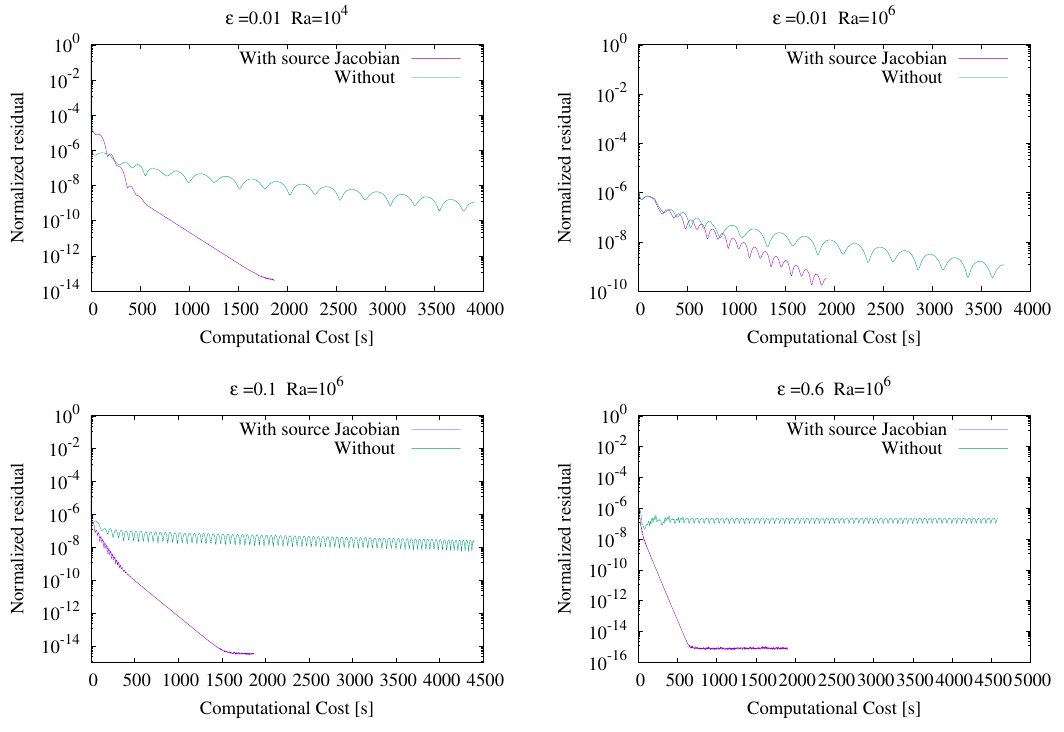
Figure 7. Buoyancy-driven square cavity. Full Navier–Stokes with the HH stabilization matrix. Comparison of